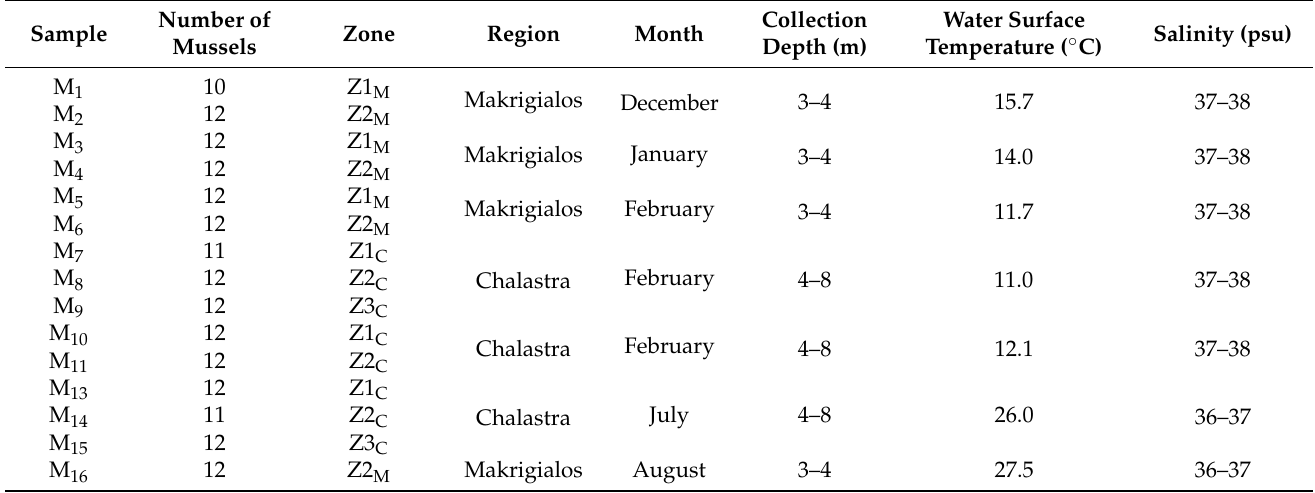
Table 1. Number of mussels used for each sample (total number of mussels for all samples = 176), sampling zone, collection period and characteristics of each region (the water surface temperature and salinity data were obtained from poseidon.hcmr.gr, accessed on 20 September